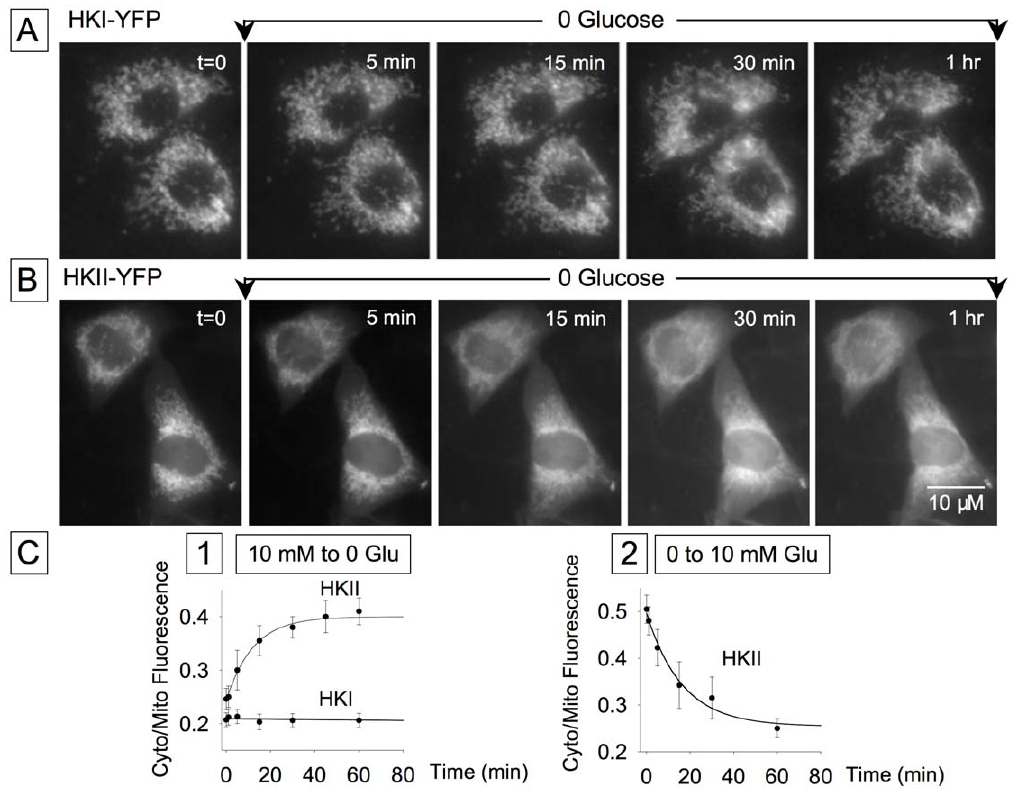
Figure 6. Removal of glucose causes translocation of HKII, but not HKI, into the cytosol. Images in Panel A obtained with HKI-YFP expressed in CHO cells show that removal of glucose did not affect HKI interaction with mitochondria. In contrast, HKII begun to dissociate from mitochondria 5 min after glucose removal (B). Panel C shows the rates measured as ratio of fluorescence intensity obtained from intracellular domains without and with mitochondria. In almost all cases the region without mitochondria was selected at the cell periphery and that with mitochondria was selected near the nucleus. C1 is a comparison of the rates of HKI and HKII dissociation in response to glucose removal. C2 shows the rate of HKII reassociation with mitochondria after glucose readdition.